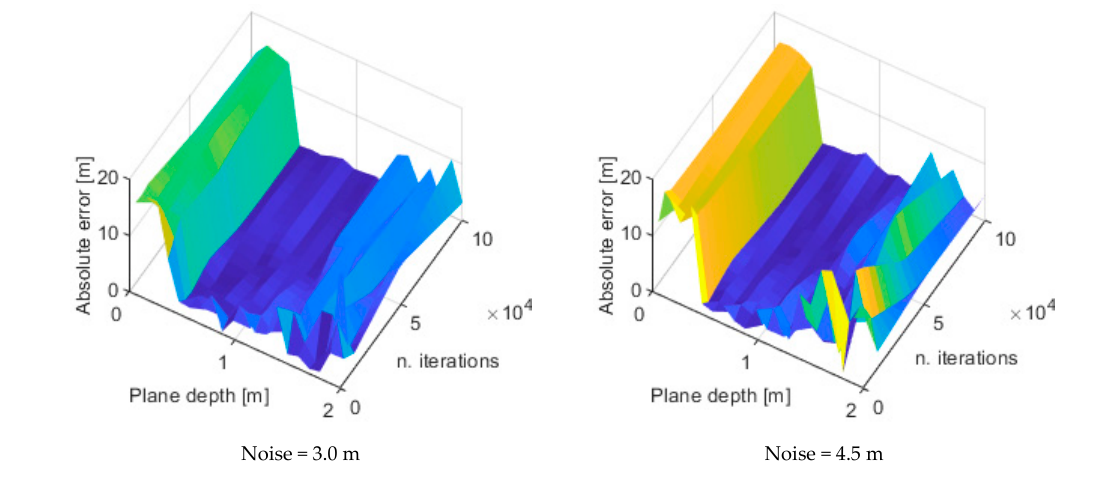
Figure 9. Error maps for different noise levels.